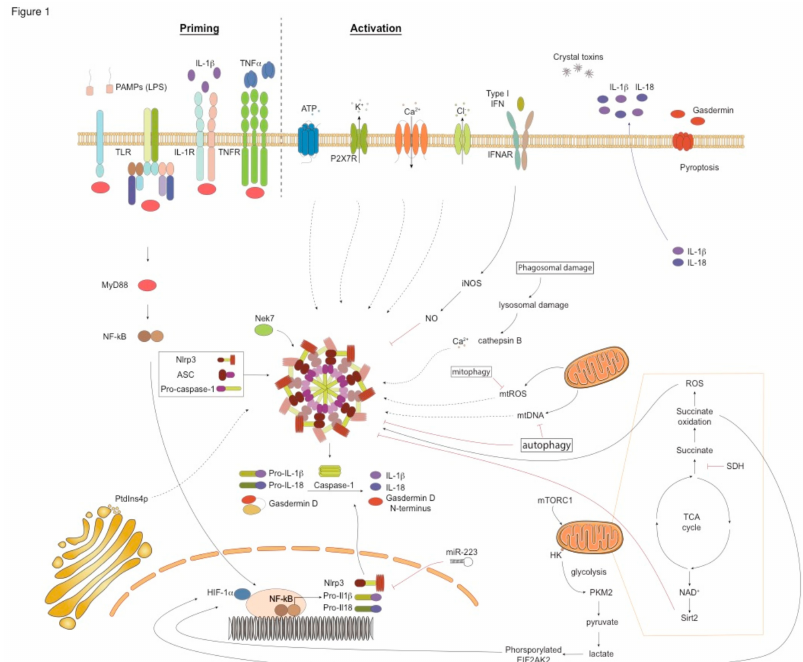
Figure 1. Mechanisms involved in activation and regulation of NLRP3 canonical pathway. NLRP3 inflammasome activation requires two signals. The “priming” signal is triggered by PAMP / DAMP recognition by PPRs (e.g. TLRs) and certain cytokines (e.g. TNF- α , IL-1 β ) and activates NF- κ B in the cell nucleus. This leads to NLRP3, pro-IL1- β and pro-IL-18 gene transcription. The second signal induces the assembly of NLRP3, ASC, and caspase-1 to form an active NLRP3 inflammasome and ultimately leads to the release of mature IL-1 β and IL-18. Gasdermin D is cleaved and becomes inserted into the cell membrane, forming pores and inducing pyroptosis. The mechanisms proposed for the second NLRP3 activating signals are shown and include: a) changes in cytosolic levels of ions, such as K + , Cl - and Ca + 2 , b) lysosomal destabilization and the release of cathepsins, c) mitochondrial dysfunction-derived signals such as mtROS, mtDNA and d) metabolic changes. PtdIns4P on dTGN drive NLRP3 activation. Aerobic glycolysis pathways and the TCA cycle also activate NLRP3. Autophagy and mitophagy inhibit NLRP3 inflammasome activation. IFNs also inhibit NLRP3 activation through NO production. IL-1R, IL-1 β receptor; TLR, Toll-like receptor; TNFR, tumor necrosis factor receptor; IFNAR, IFN α / β receptor; NEK7, NIMA- related kinase 7; NF- κ B, nuclear factor- κ B; P2X7, P2X purinoceptor 7; PtdIns4P, phosphatidylinositol-4-phosphate; PYD, pyrin domain; ROS, reactive oxygen species; HK1, hexokinase; mTORC1, rapamycin complex 1; SDH, succinate dehydrogenase; EIF2AK2, eukaryotic translation initiation factor 2-alpha kinase